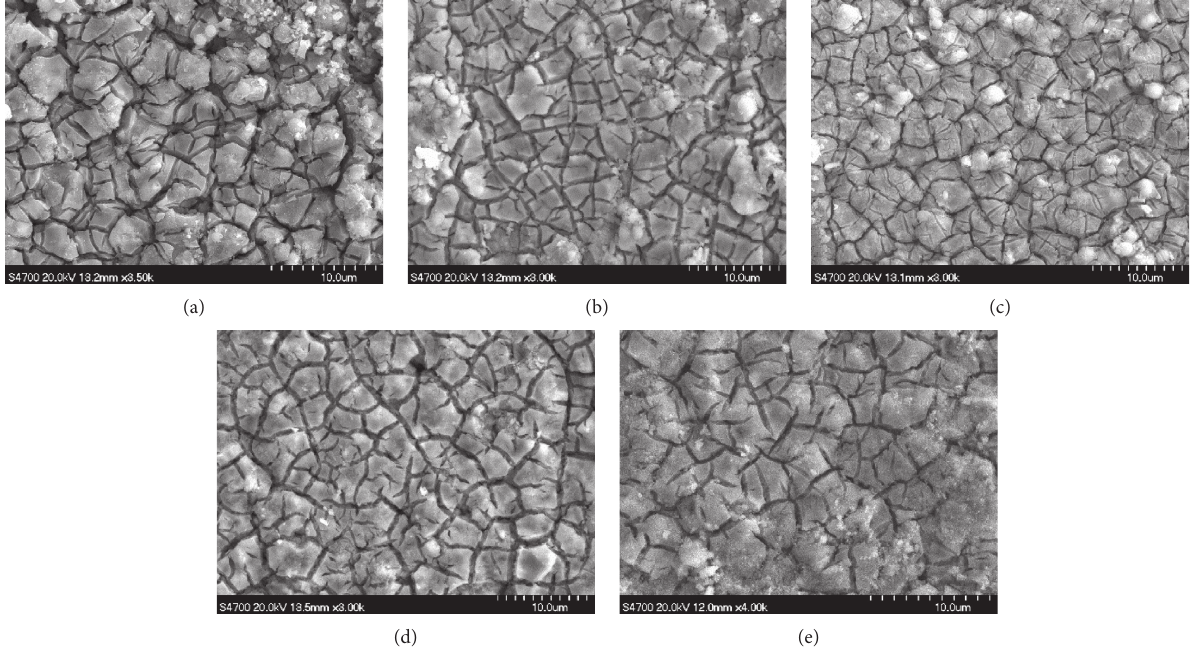
Figure 2: SEM images of Ti/SnO 2 -Sb-Ni/Ce electrodes with (a) Ni (0%), (b) Ni (1%), (c) Ni (2%), (d) Ni (3.5%), and (e) Ni